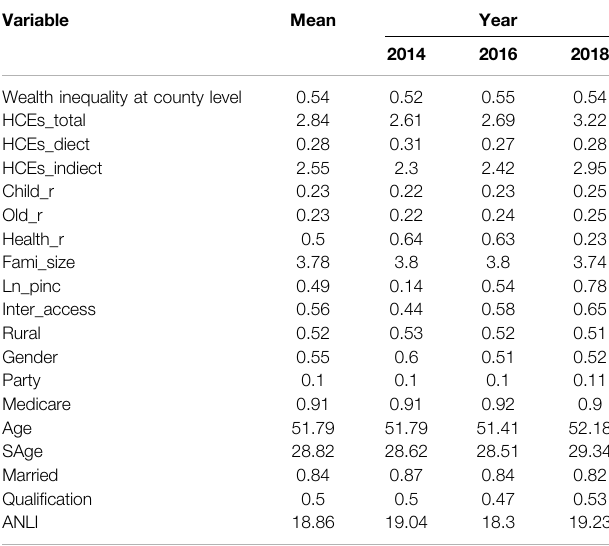
TABLE 2 | Description of county-level wealth inequality, household carbon emissions per capitaland controlvariables. Source: Calculated bytheauthors based on CFPS, IOTs and CEADs in